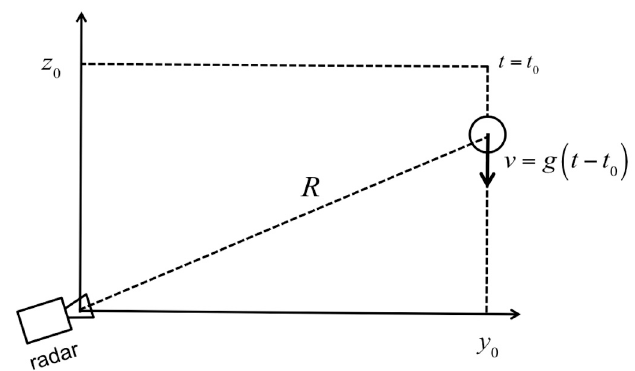
Figure 5. Simulation set-up of the free-falling target.